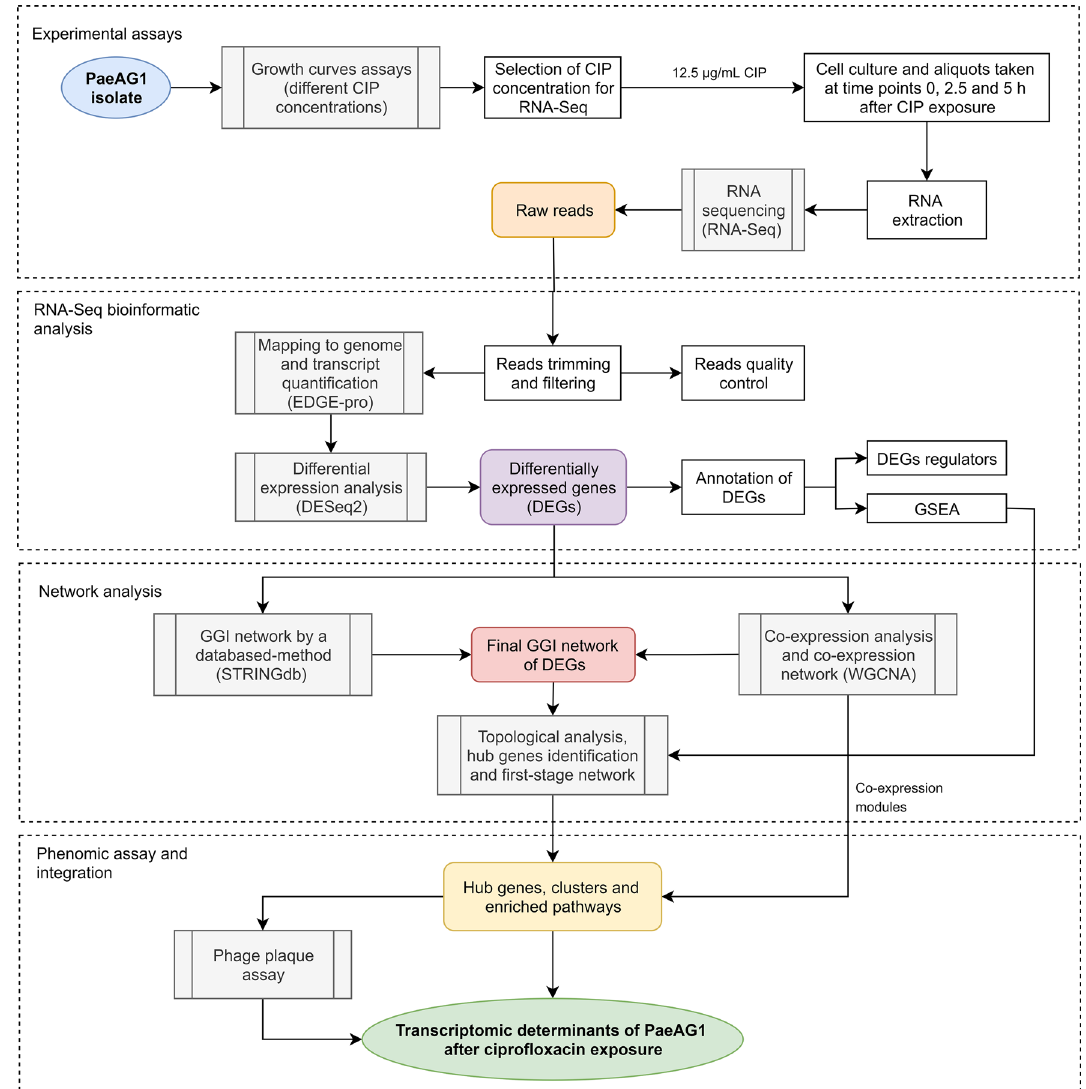
Figure 1. General pipeline to identify the transcriptomic determinants of the response of P. aeruginosa AG1 to ciprofloxacin (CIP). After growth curves assessment, a specific CIP concentration was used to sequence RNA (RNA-Seq) at 0, 2.5 and 5 h after exposure. DEGs were identified and used to build GGI networks. Transcriptomic determinants were identified by network analysis. Findings were verified at phenomic level using a phage plaque